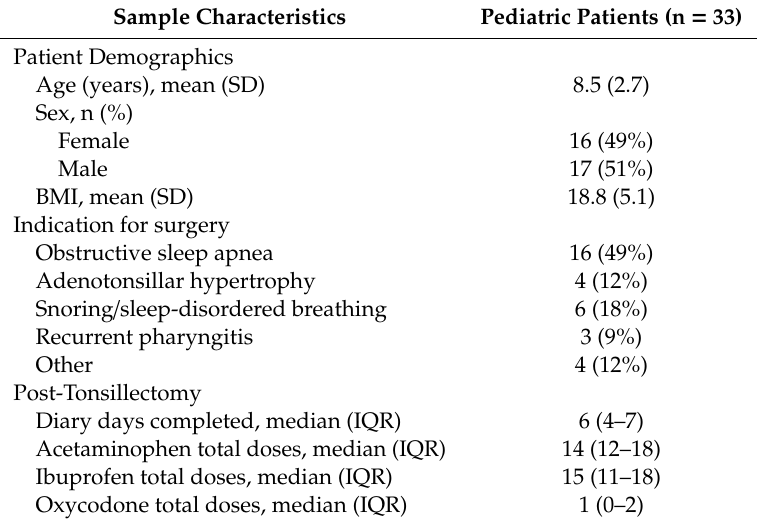
Table 1. Patient